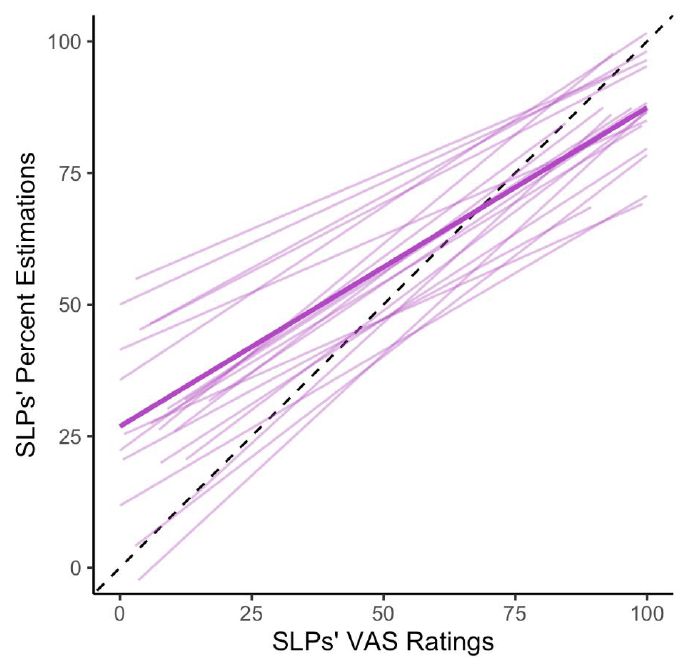
Figure 3. Relationship between SLPs’ VAS Ratings and Percent Estimations. The lighter lines depict the relationship between percent estimations and VAS ratings for each SLP in the study, while the darker line represents the average relationship between these two measures. The black dotted line represents the perfect theoretical relationship between these two measures. Alternate visualization for this figure can be found in the supplementary materials (https://osf.io/sr9aw/) (accessed on 21 June 2022).